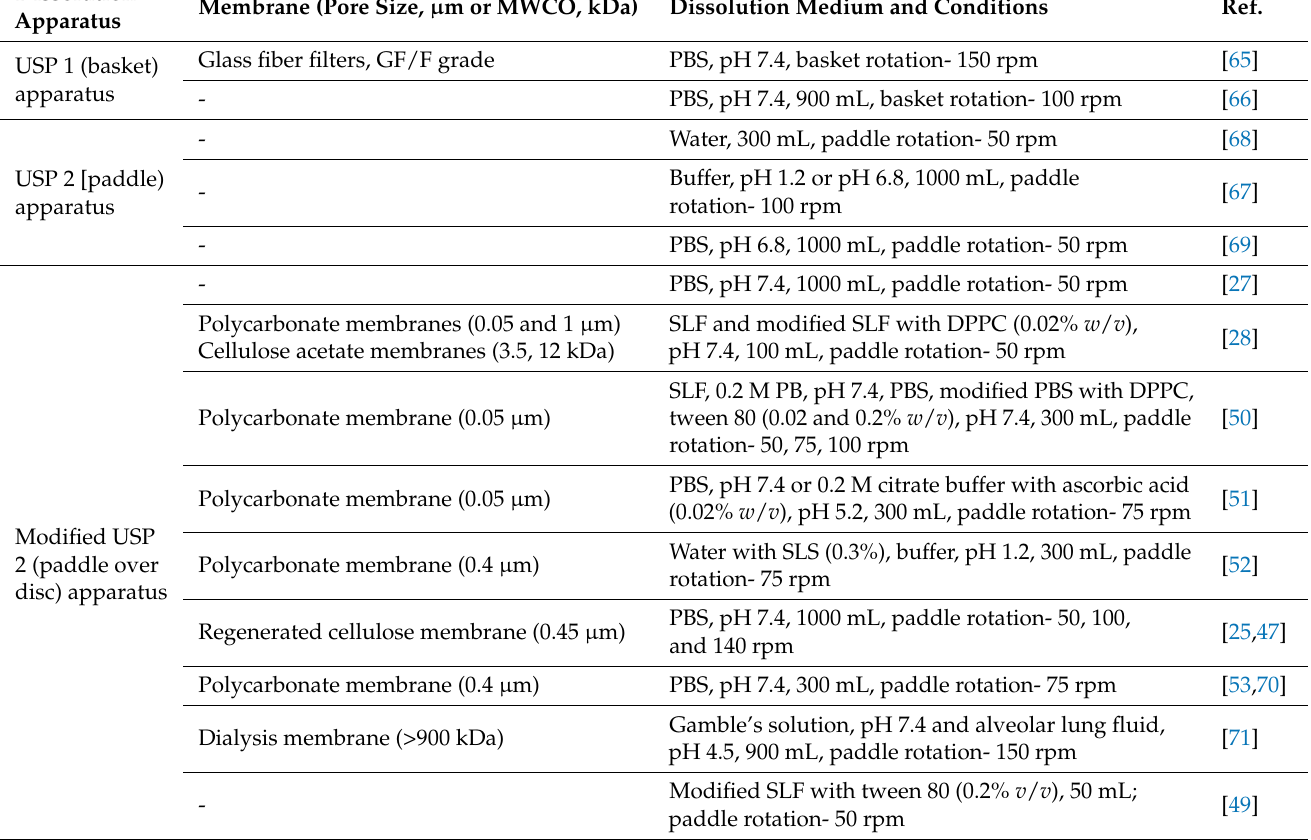
Table 2. Summary of various in vitro dissolution testing methods for dry powder